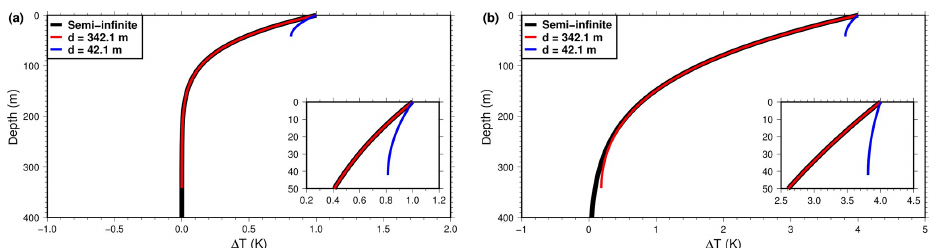
Figure 1. Departure from the initial temperature profile due to constant rate of surface temperature increase of 0.01Kyr − 1 . Analytical solutions for the half-space model (black) and for the finite thickness model with bottom boundary at 42.1m (blue) and at 342.1m (red). (a) Temperature anomaly after 100 years. (b) Temperature anomaly after 400